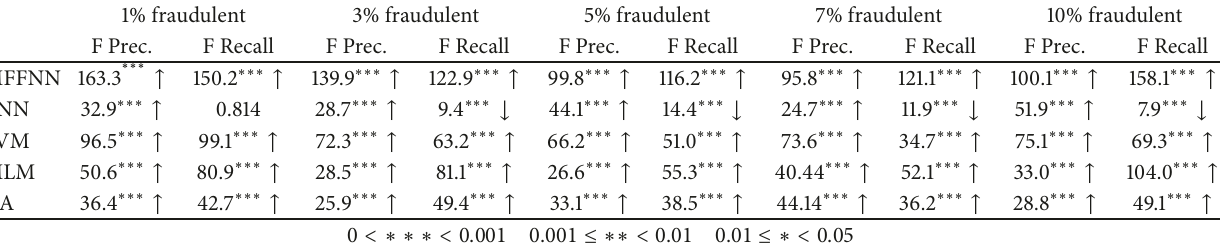
Table 9: The result of one-way ANOVA for mean comparison of each method for given proportions of fraudulentcompanies. The downward (upward) arrow shows a strictly decreasing (increasing) trend. 1% fraudulent 3% fraudulent 5% fraudulent 7% fraudulent 10% fraudulent F